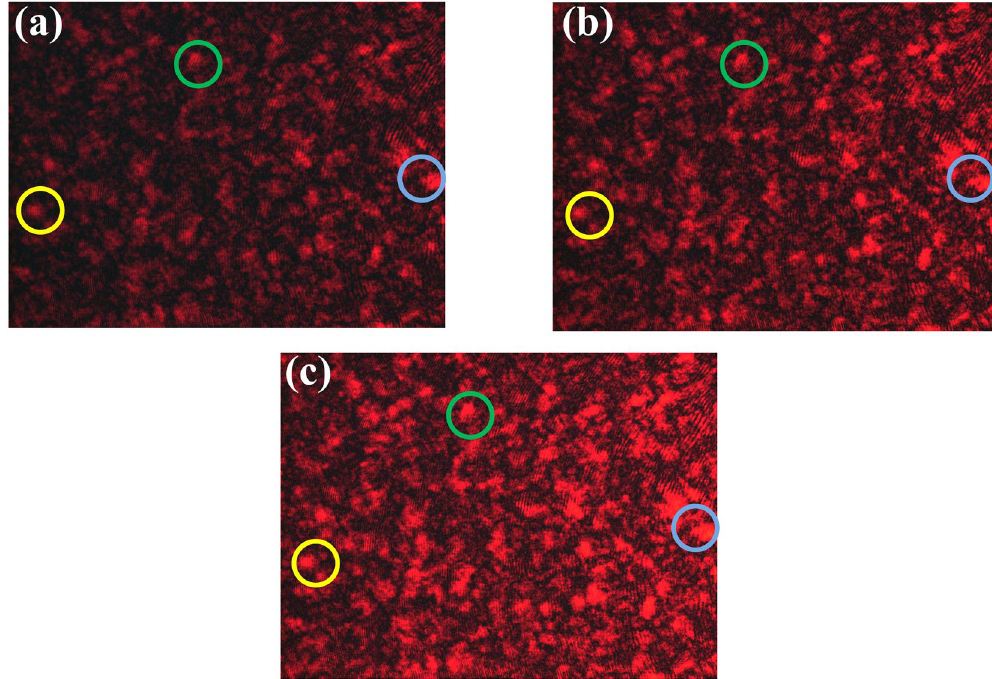
Figure 3. The speckle patterns in Step III. ( a ) Is the speckle pattern of the reflected light with vertical polarization through PBS 1 from laser 2. ( b ) Is the speckle pattern of the transmitted light with horizontal polarization from laser 1. ( c ) Is the image of the speckle pattern when both laser light beams are focused on the RGGP at the same time. Though the intensities of light in ( a , b ) are not identical, the speckle patterns are almost same.